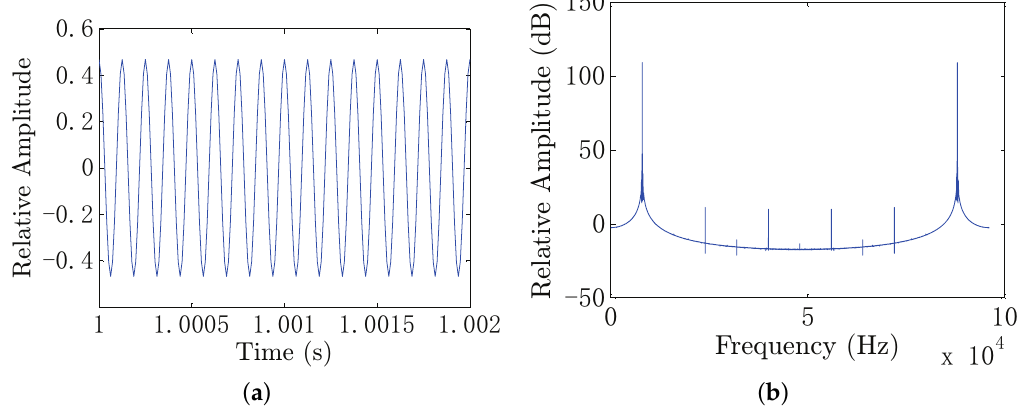
Figure 17. ( a ) The measured data after the high Q bandpass filter in the time domain; ( b ) the frequency spectrum of the measured data after the